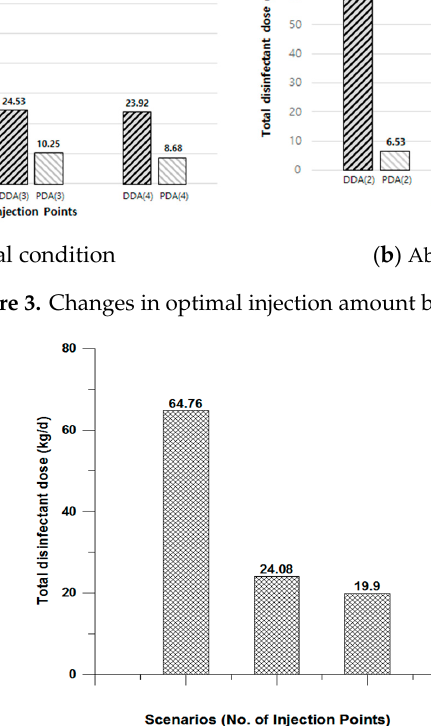
Figure 4. Changes in optimal rechlorination injection amount for 2, 3, and 4 points, using harmony search (Yoo et al. [6]).